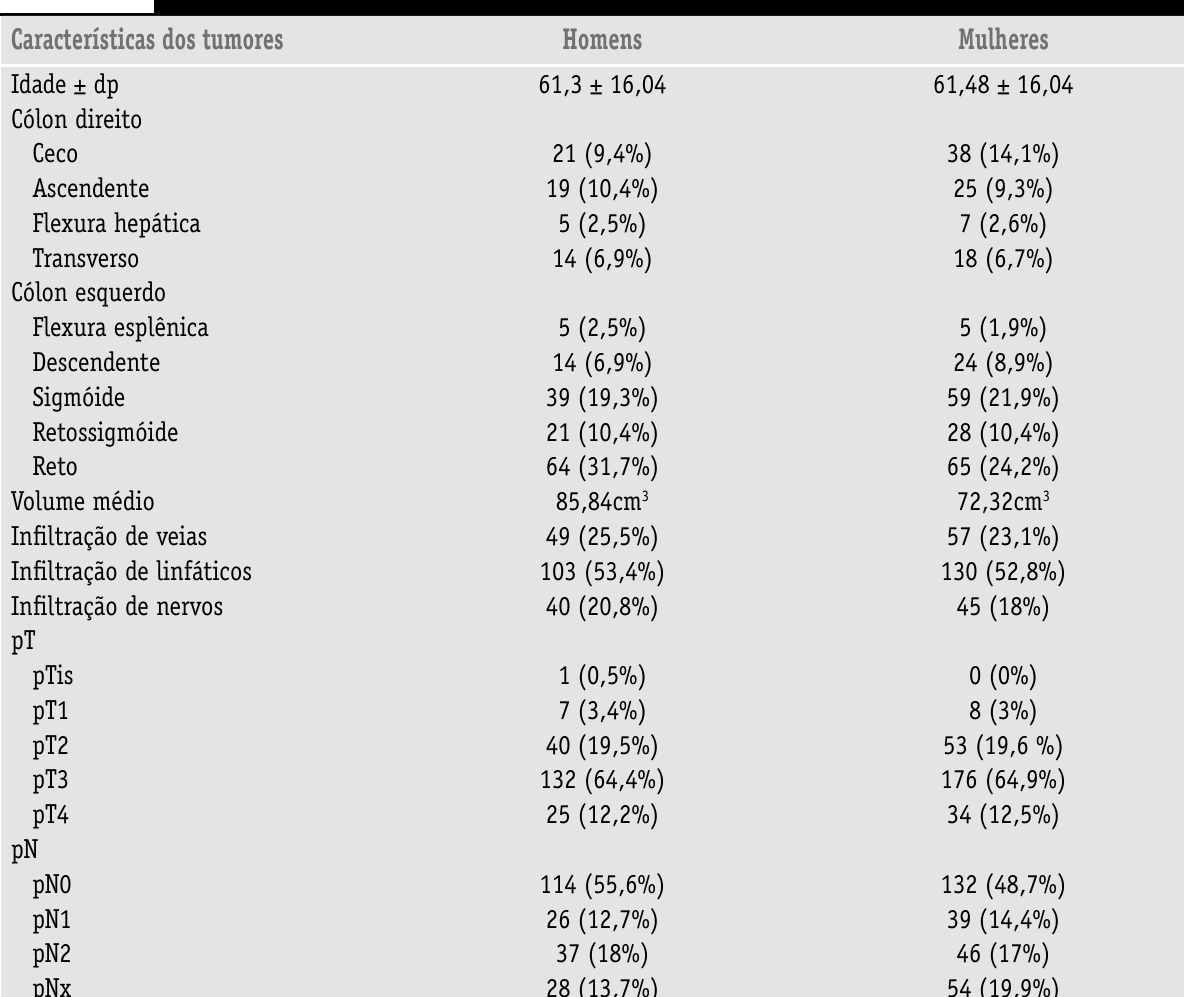
Figura 3 – Distribuição de 476 casos de carcinoma colorretal em relação à `profundidade do tumor (pT) segundo o sistema TNM